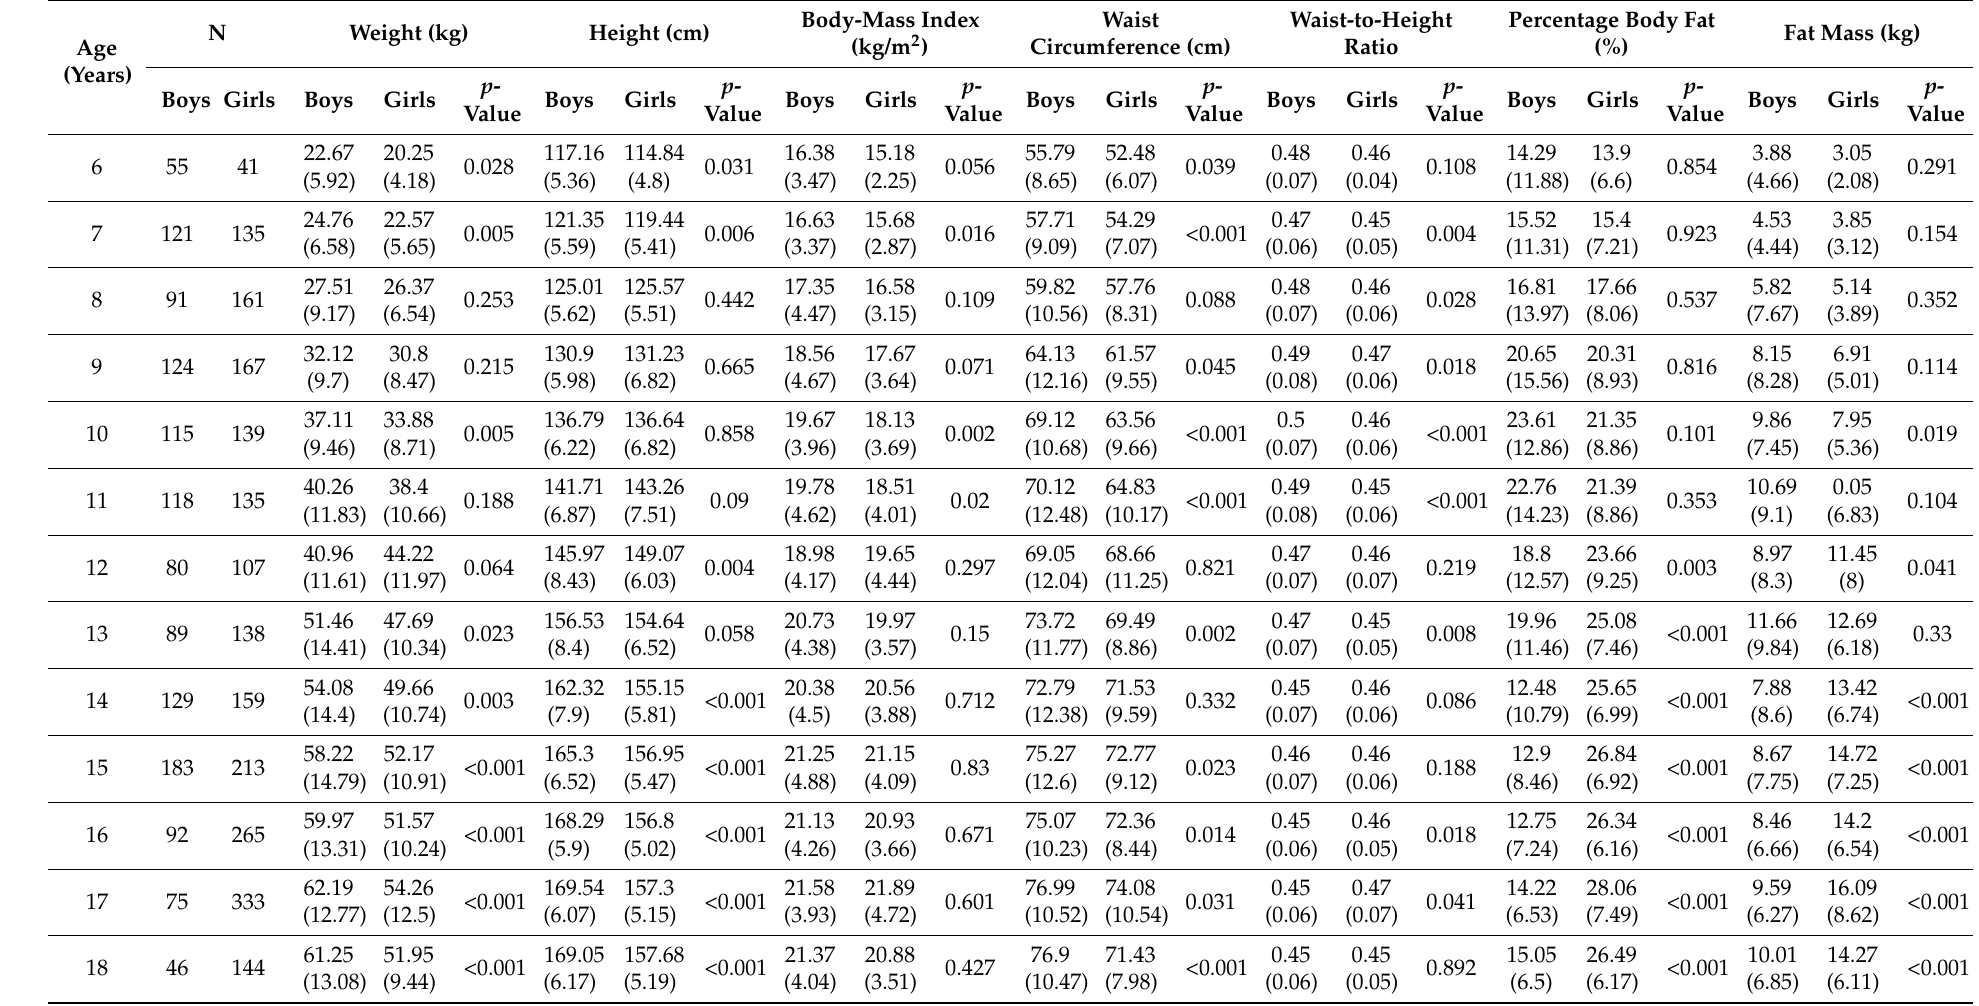
Table 2. Mean (standard deviation) anthropometric measurements and percentage body fat, according to age and sex, in the boys and